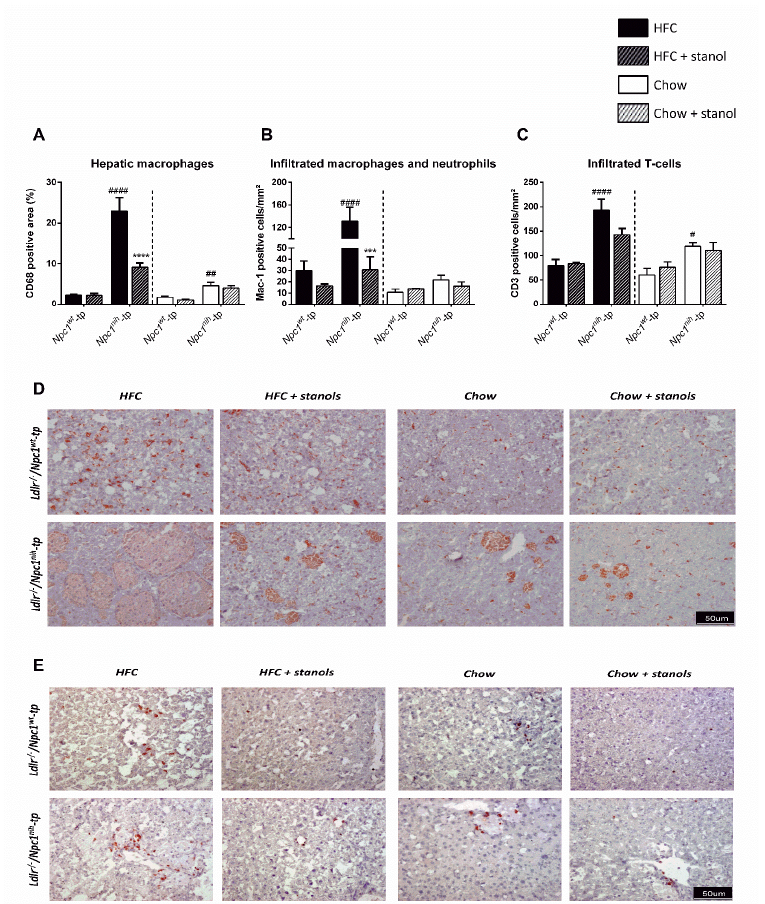
Figure 5. Hepatic inflammation-related immunohistochemistry: HFC and chow diets. ( A – C ) Quantification of hepatic macrophages (CD68), infiltrated hepatic macrophages and neutrophils (Mac-1), and infiltrated hepatic T-cells (CD3). ( D , E ) Representative pictures of liver sections stained for hepatic macrophages and infiltrated macrophages. All error bars represent standard error of the mean. Statistical significance is indicated as follows: Npc1 nih -tp mice on a HFC or chow diet vs. Npc1 wt -tp mice on a HFC or chow diet (# p ≤ 0.05; ## p < 0.01; #### p < 0.0001); Npc1 wt -tp or Npc1 nih -tp on